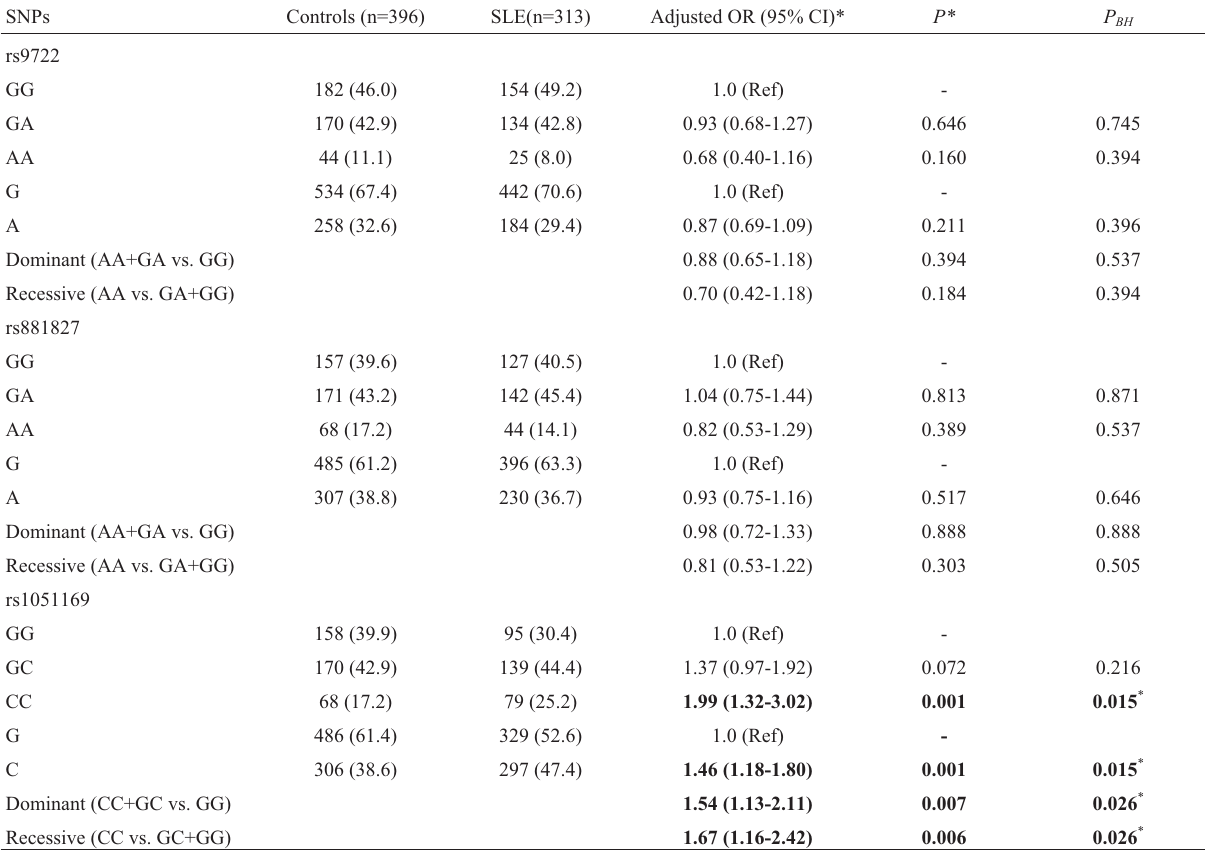
Table 2 - Association between S100B polymorphisms and risk of SLE.